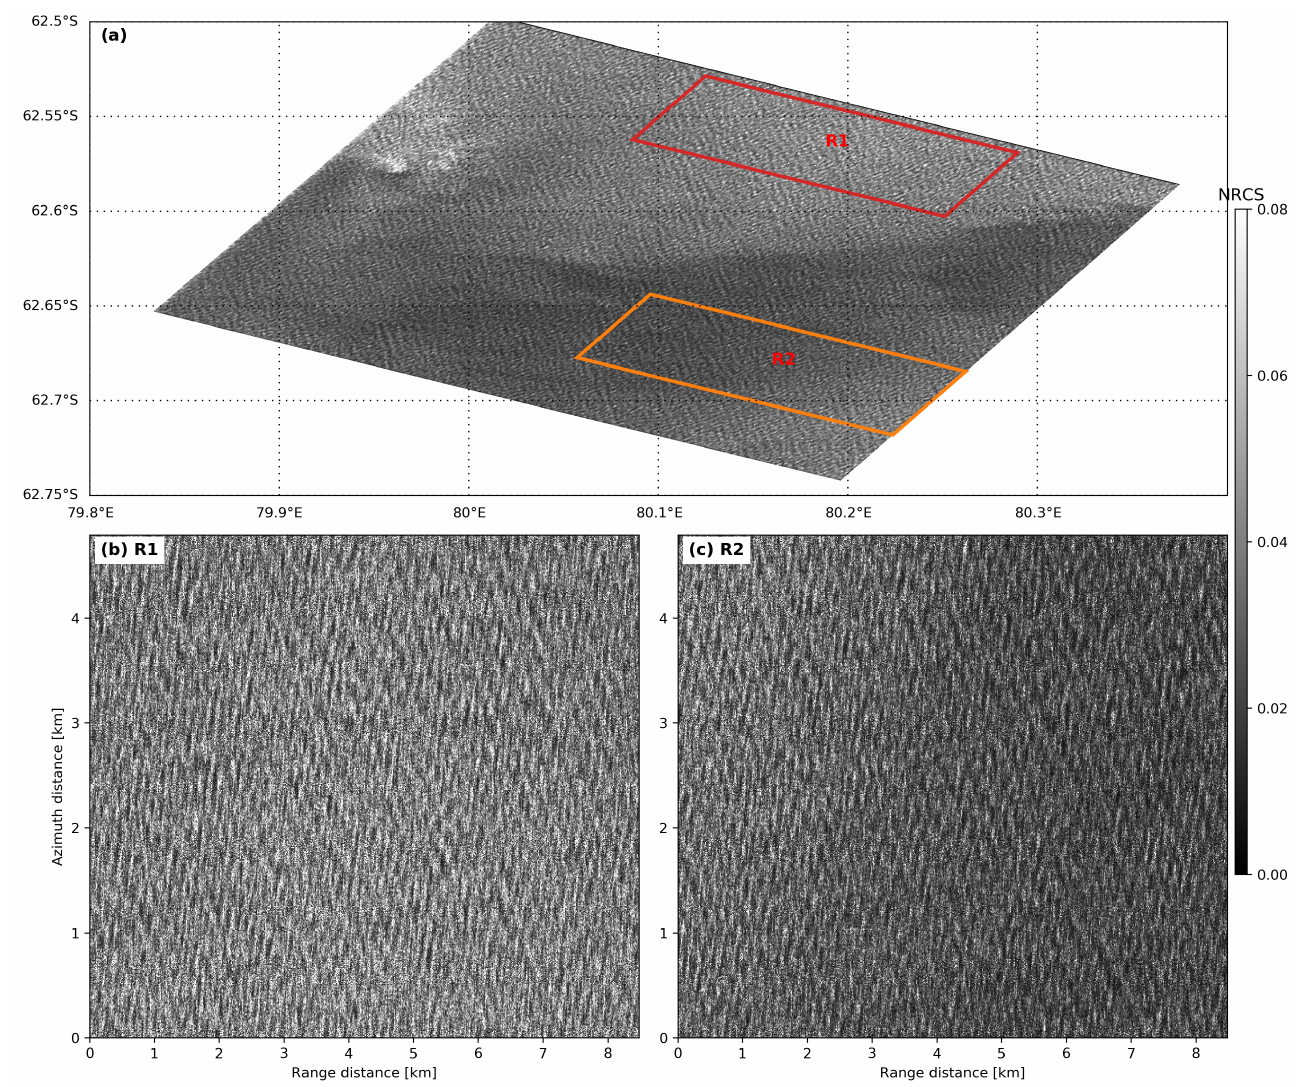
Figure 2. ( a ) An example case of SAR imagery over the MIZ. Two regions of interest over open water (marked by ‘R1’) and the wave in ice (marked by ‘R2’) are annotated. Zoomed-in images of R1 and R2 are shown in ( b ) and ( c ),